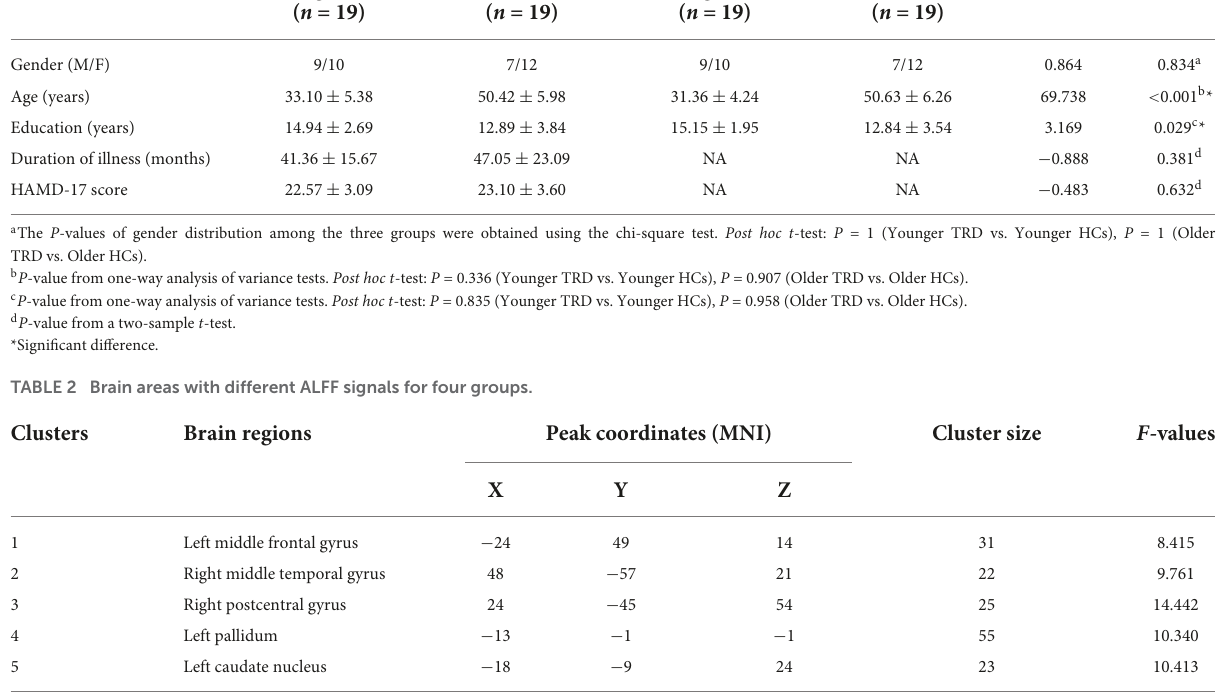
TABLE 1 Demographic and clinical characteristics of the study participants. Variable